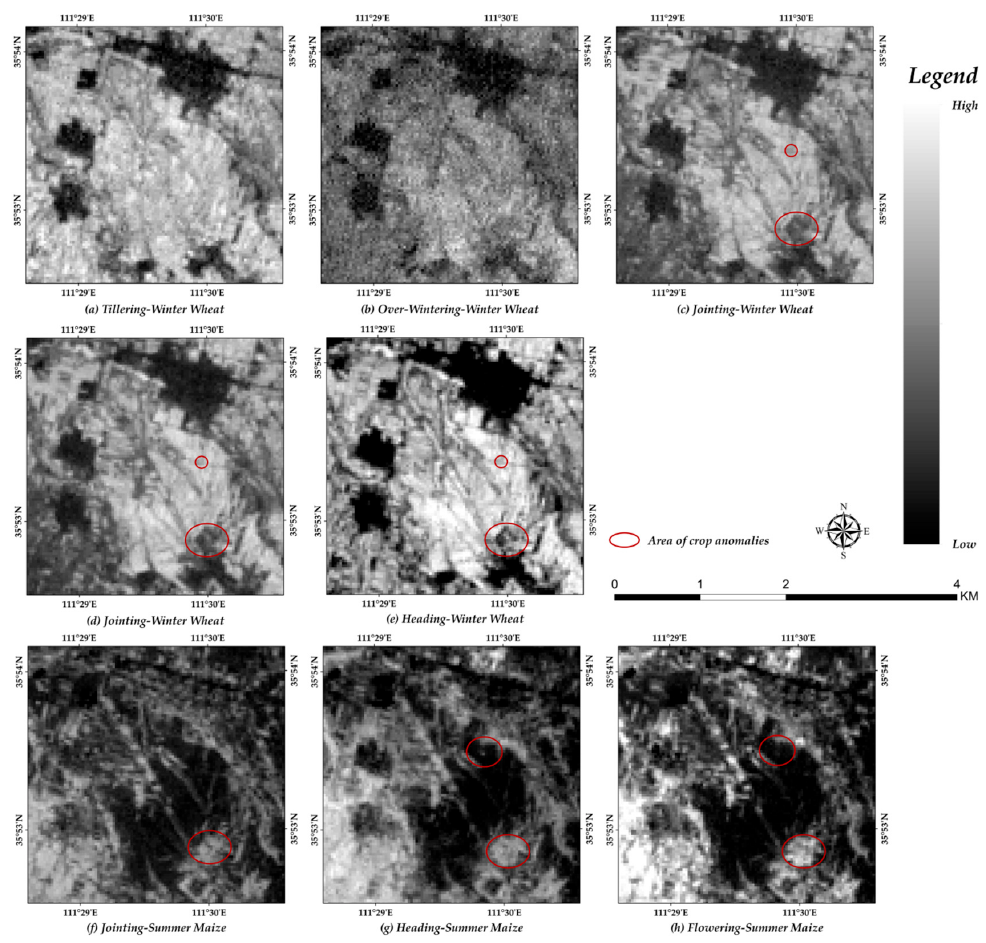
Figure 5. Landsat NDVI data time series images from 2001–2002 of Taosi. Winter wheat: ( a ) Tillering (16 November 2001); ( b ) Over-wintering (4 February 2002); ( c ) Jointing (9 March 2002); ( d ) Jointing (24 March 2002); ( e ) Heading (18 April 2002). Summer maize: ( f ) Jointing (29 June 2002); ( g ) Heading (30 July 2002); ( h ) Flowering (31 August 2002). The negative crop or positive anomalies caused by the southeast small town of worship and sacrifice can be identified in images ( c – h ), the dense storage area shows negative anomalies in images ( c – e ), the palace area shows positive anomalies in images ( g ) and ( h ). Table 3. Distance measurements result for Taosi site.